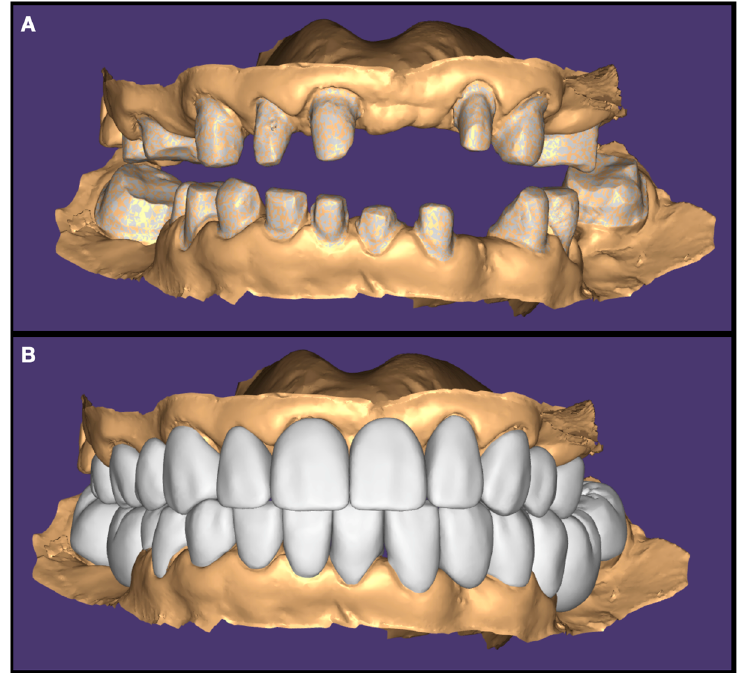
Figure 10. Final imaging. ( A ) Final digital impression. ( B ) Design of final restorations. The 3D facial scanner was evaluated with the proposed final restorations (Figure 11).